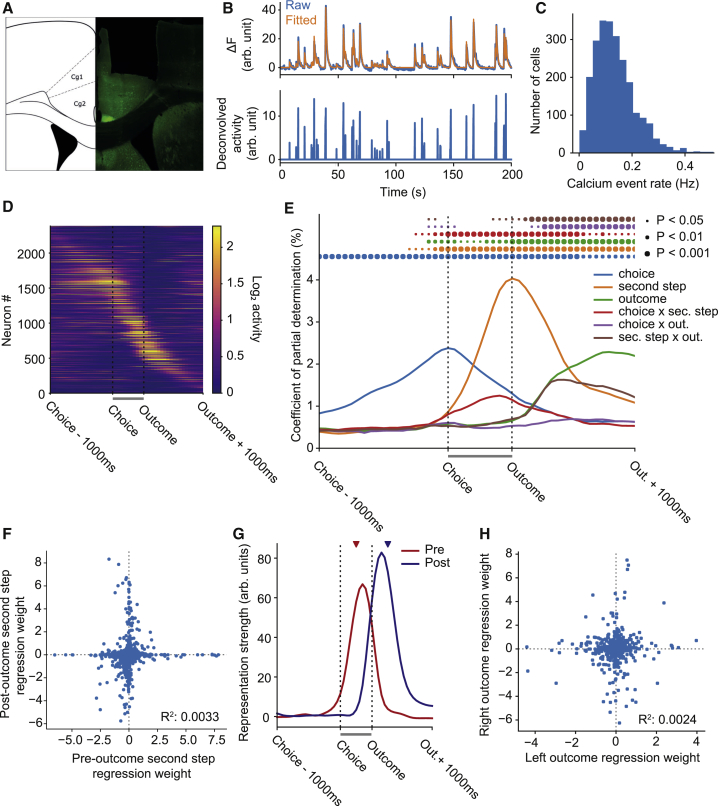
Two-Step ACC Calcium Imaging(A) Example GRIN lens placement in ACC.(B) Fluorescence signal from a neuronal region of interest (ROI) identified by CNMF-E (top panel, blue) and fitted trace (orange) due to the inferred deconvolved neuronal activity (bottom panel).(C) Histogram showing the distribution of average event rates across the population of recorded neurons. Events were defined as any video frame on which the inferred activity was non-zero.(D) Average trial aligned activity for all recorded neurons, sorted by the time of peak activity. No normalization was applied to the activity. The gray bars under (D), (E), and (G) between choice and outcome indicate the time period that was warped to align trials of different duration.(E) Regression analysis predicting activity on each trial from a set of predictors coding the choice (top or bottom), second step (left or right), outcome (rewarded or not) that occurred in each trial, and their interactions. Lines show the population coefficient of partial determination (CPD) as a function of time relative to trial events. Circles indicate where CPD is significantly higher than expected by chance, assessed by permutation test with Benjamini-Hochberg correction for comparison at multiple time points.(F) Representation of the second-step state before and after the trial outcome. Points show second-step predictor loadings for individual neurons at a time point halfway between choice and outcome (x axis) and a time point 250 ms after trial outcome (y axis).(G) Time course of pre- and post-outcome representations of second-step state, obtained by projecting the second step predictor loadings at each time point onto the pre- and post-outcome second-step representations. The red and blue triangles indicate the time points used to define the projection vectors.(H) Representation of trial outcomes (reward or not) obtained at the left and right poke. Points show predictor loadings for individual neurons 250 ms after trial outcome in a regression analysis in which outcomes at the left and right poke were coded by separate predictors. The regression analysis was identical to that shown in (E) except that the outcome and second-step x outcome predictors were replaced by left outcome and right outcome predictors, which coded reward/non-reward in trials that reached the left or right second-step state, respectively.